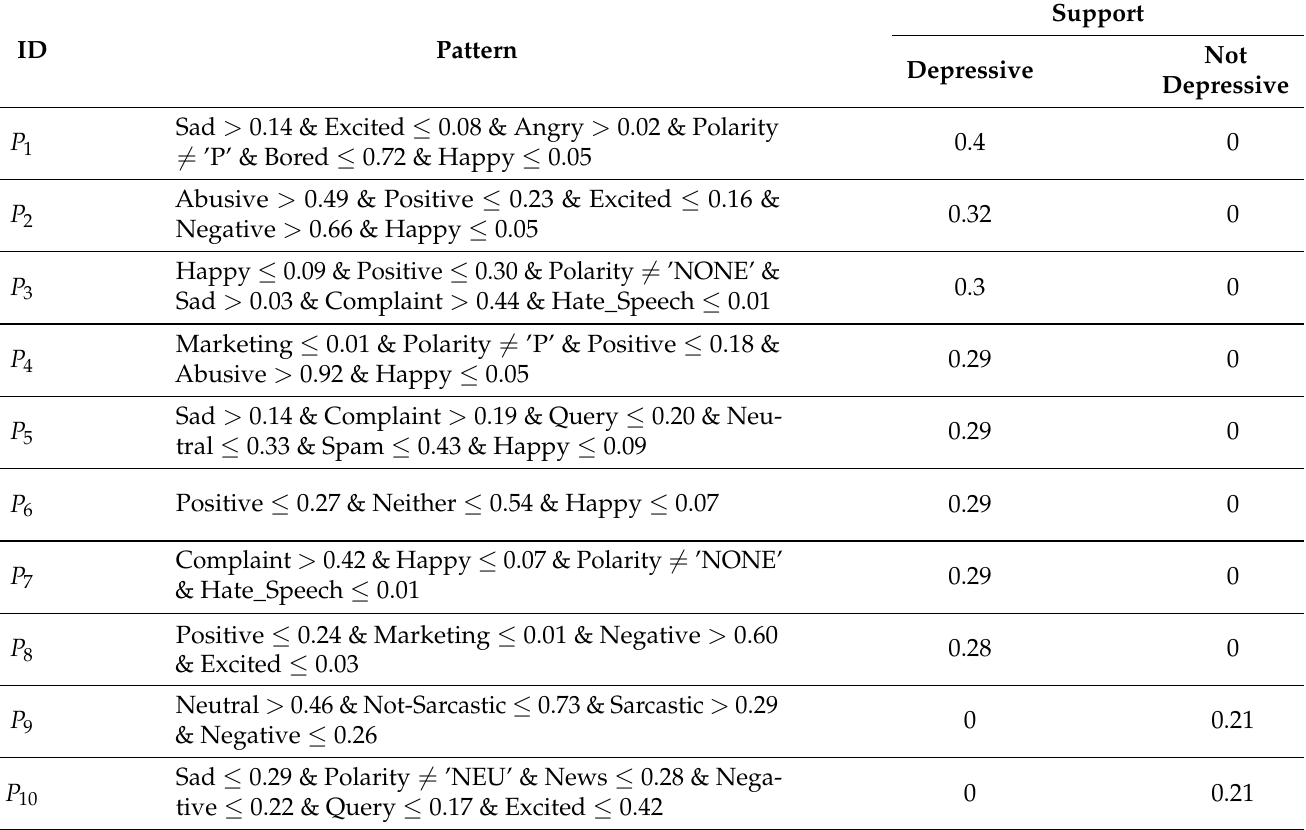
Table 9. Example of contrast patterns obtained, showing the support for depressed and not depressed posts.